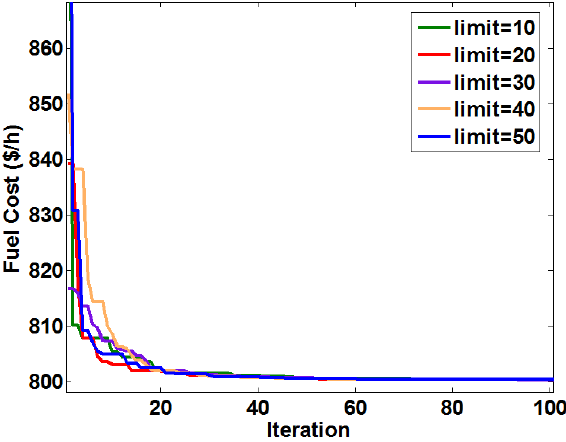
Figure 5. Convergence characteristics obtained by the IABC algorithm with different parameter limit values for OPF with total fuel